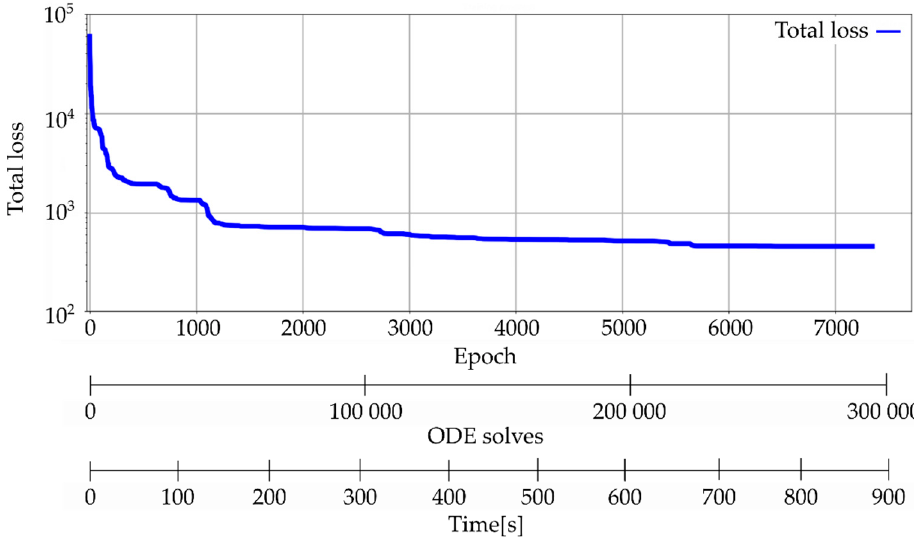
Figure 5. The convergence of the training process (using greedy random adaptation particle swarm optimizer (GRAPSO)).